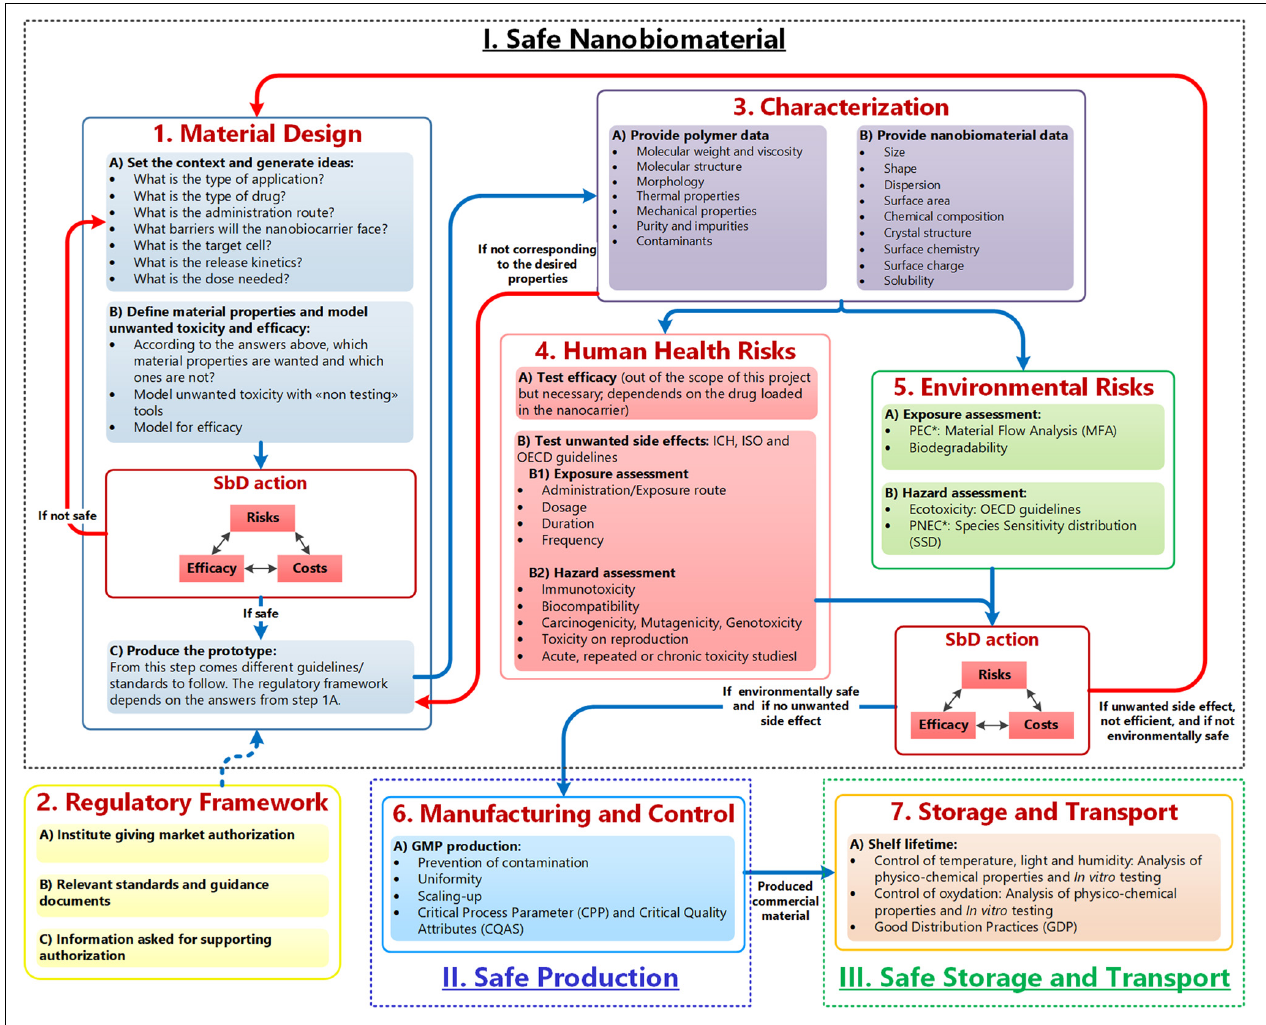
FIGURE 1 | GoNanoBioMat SbD approach. The blue arrows correspond to the flow of polymeric NBMs from design to storage and transport. The red arrows are feedback loops used whenever the NBM is unsafe, or inefficient. Adapted from Som et al. (2019). *PEC, predicted environmental concentration; PNEC, predicted no effect